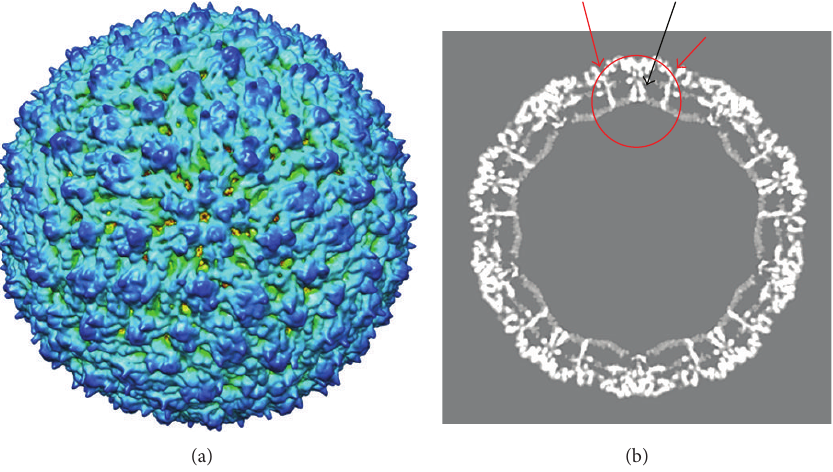
Figure 3: (a) Dengue 2 New Guinea C cryoEM reconstruction rendered at 3.5 ˚A, EMD 5520. The view is down the icosahedral 5-fold axis. Although this is termed a mature virus because of the smooth appearance, preM may still be associated with the virus. The surface of the structure has few distinctive features; however, it has been proposed that, upon maturation, the virus E protein undergoes major conformational changes as infection is initiated. (b) This image is a slice of the virus down the 2-fold axis. M (black arrow) and E (red arrow), transmembrane domains are seen below the outer surface. Distortion of the lipid membrane is seen where the transmembrane domains penetrate and no organized capsid structure is detected (circled). Compare to the alphavirus slice in Figure 1 where the nucleocapsid structure is clearly delineated. Reprinted with permission from Zhang et al. [23]. See EM DATA BANK (EMDB)/5520 for full resolution images.